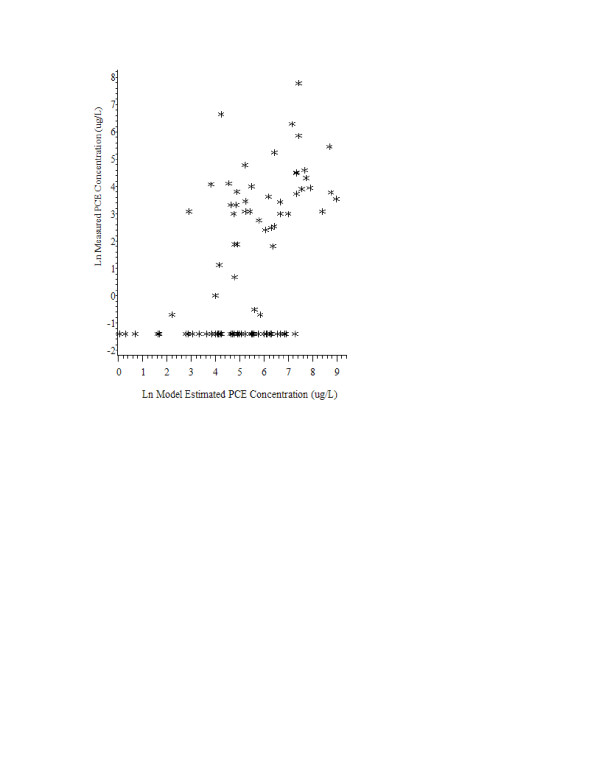
Loge measured PCE verses loge model estimated PCE concentrations (ug/L).